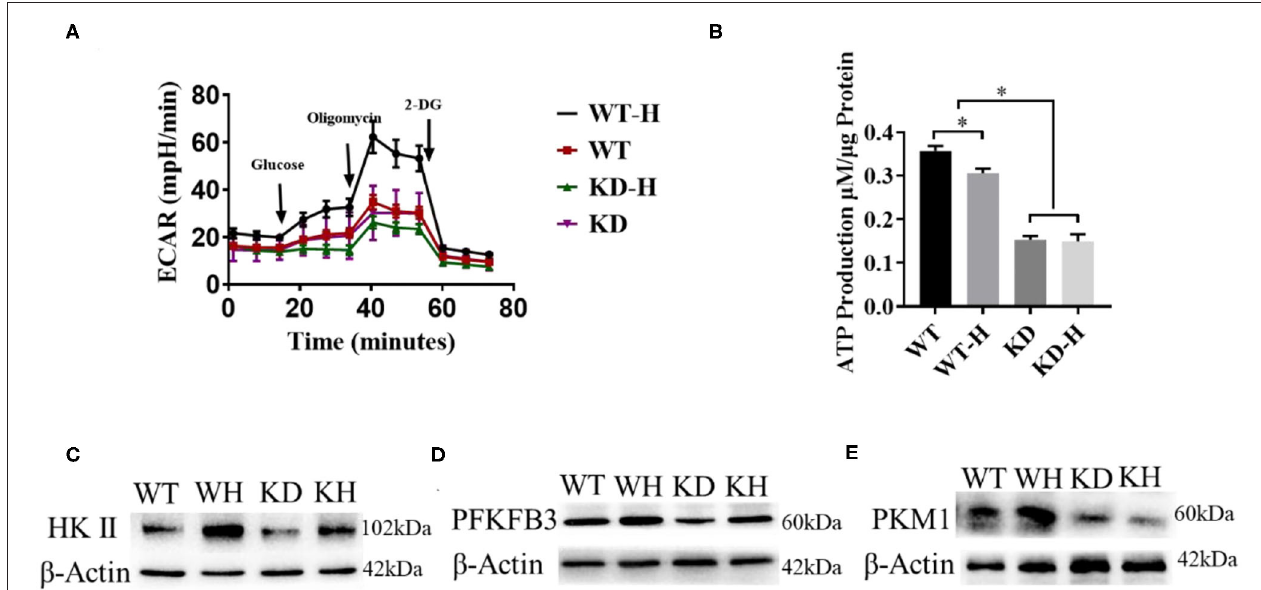
FIGURE 5 | Effect of gamma-aminobutyric acid type B receptor subunit 2 (GABBR2) knockdown on the glycolysis capacity of human umbilical vein endothelial cells (HUVECs) after hypoxia treatment. (A) Extracellular acidification rate (ECAR) changes induced by 6h of hypoxic treatment in normal and GABBR2-downregulated HUVECs. WT , normal mice; KD , GABBR2-downregulated mice; WT-H , wild-type (WT) mice with hindlimb ischemia; KD-H , GABBR2 knockdown (KD) mice with hindlimb ischemia. (B) ATP production changes induced by 6h of hypoxic treatment in normal and GABBR2-downregulated HUVECs. (C–E) Expression changes of HKII, PFKFB3, and PKM1 induced by 6h of hypoxic treatment in normal and GABBR2-downregulated HUVECs. * p <